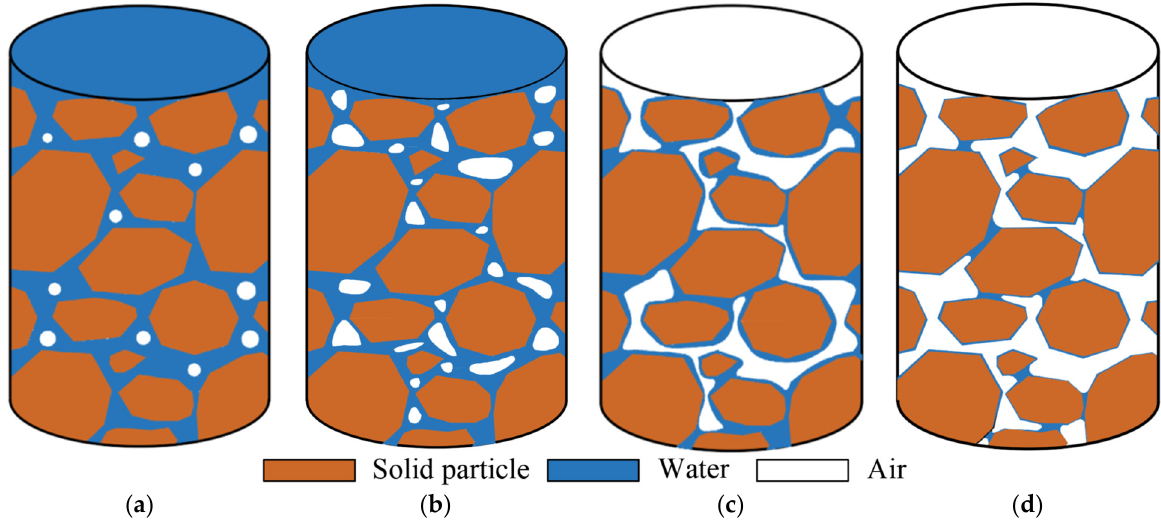
Figure 8. Matrix suction versus degree of saturation.